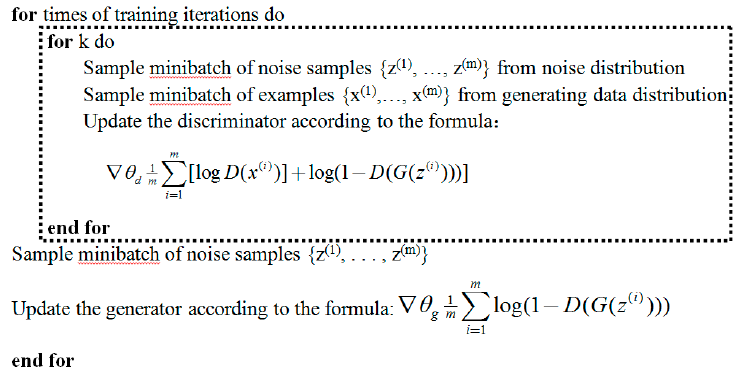
Figure 4. The algorithm of minibatch stochastic gradient descent.